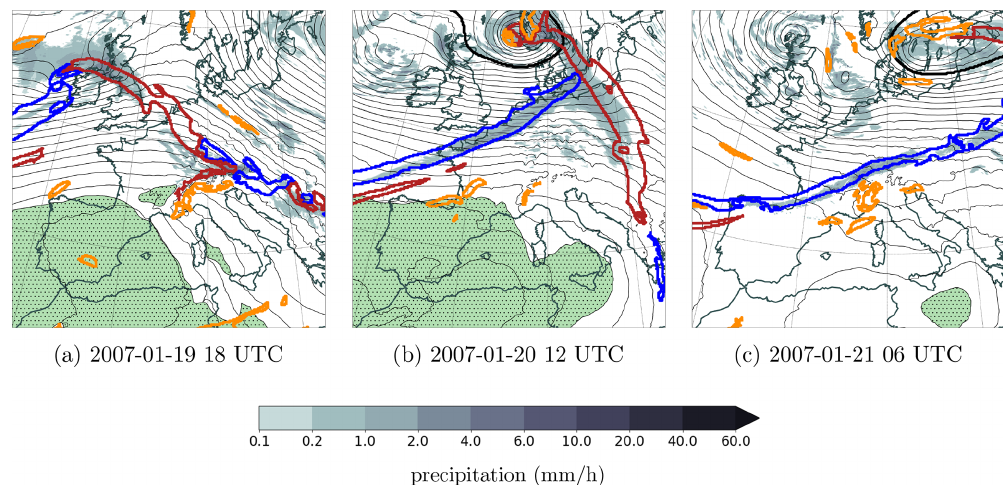
Figure 3. Development of Cyclone Lancelot in January 2007. Thin black contours indicate the geopotential at 850hPa, gray shading the surface precipitation, and green stippling the high-pressure areas. Bold contours represent the outlines of tracked features: synoptic cold and warm fronts (blue and red), local fronts of either type (orange), and cyclones (black).